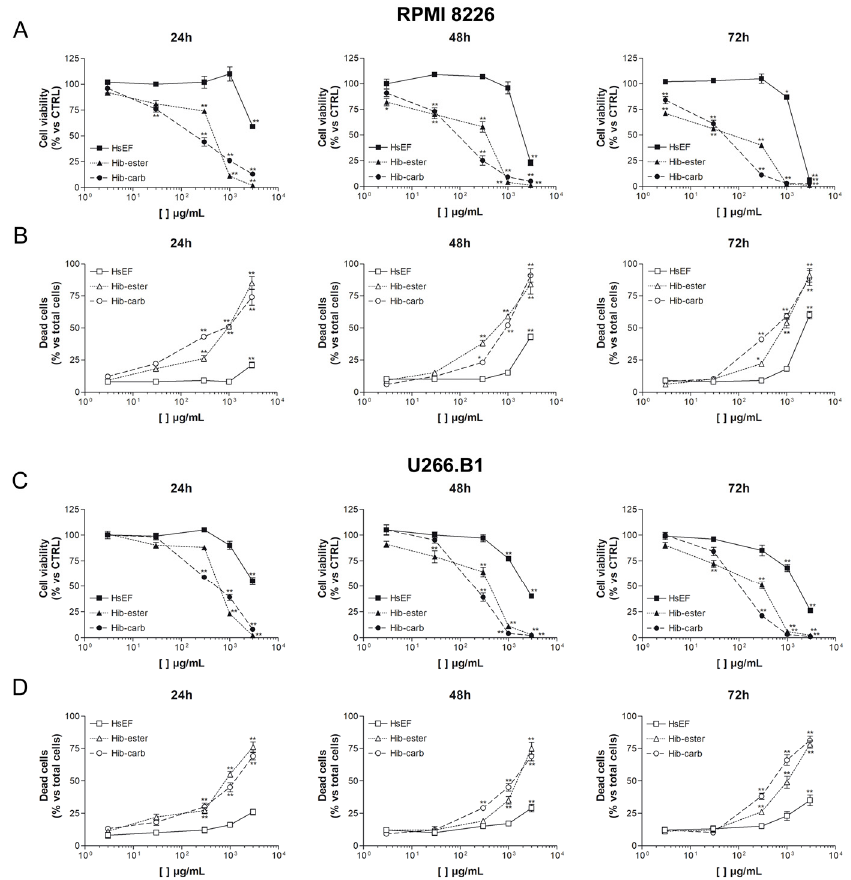
Figure 4. Trypan blue cell viability and death of RPMI 8226 and U266.B1 cells. ( A ) Cell viability and ( B ) cell death of RPMI 8226 cells treated with increasing concentrations of HsEF, Hib-ester and Hib-carbaldehyde (3 µ g/mL–3 mg/mL), and counted with trypan blue after 24, 48 and 72 h. ( C ) Cell viability and ( D ) cell death of U266.B1 cells treated with increasing concentrations of HsEF, Hib-ester and Hib-carbaldehyde (3 µ g/mL–3 mg/mL), and counted with trypan blue after 24, 48 and 72 h. Cell viability data are represented as the mean percentage ± SD and are compared to untreated controls, arbitrarily set to 100%. Cell death data are represented as the mean percentage ± SD calculated on the sum of all counted cells for each treatment (* p < 0.05, ** p < 0.01 vs.